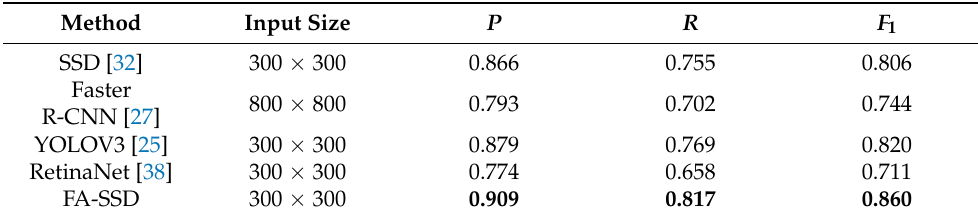
Figure 10. Visualization results of different methods. ( a – c ) Faster R-CNN. ( d – f ) YOLOV3. ( g – i ) RetinaNet. ( j – l ) FA-SSD. Table 3. Results of different